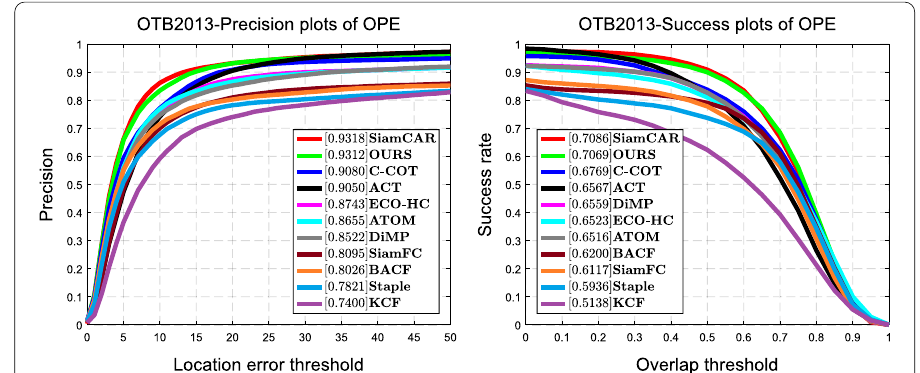
Fig. 4 Performance evaluation results of different algorithms on OTB2013 dataset